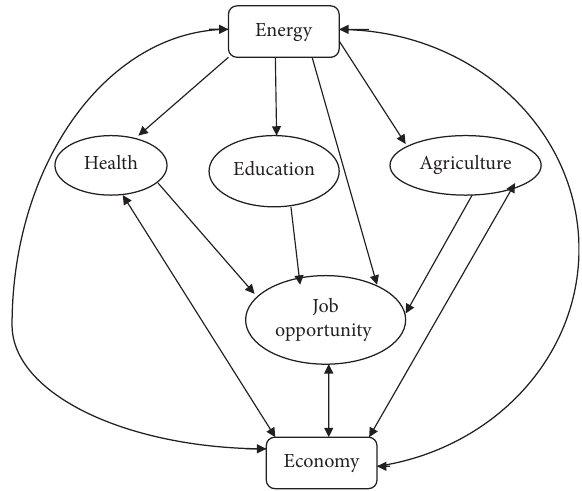
Figure 4: Relationship of energy with